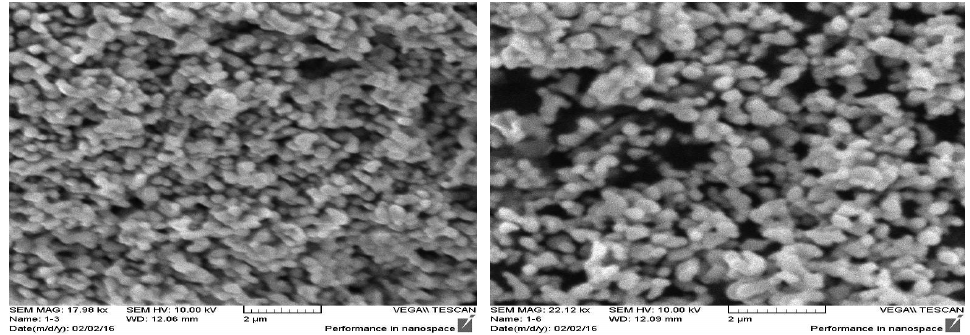
Fig. 3. SEM photographs of CuO nanoparticles prepared via precipitation method.